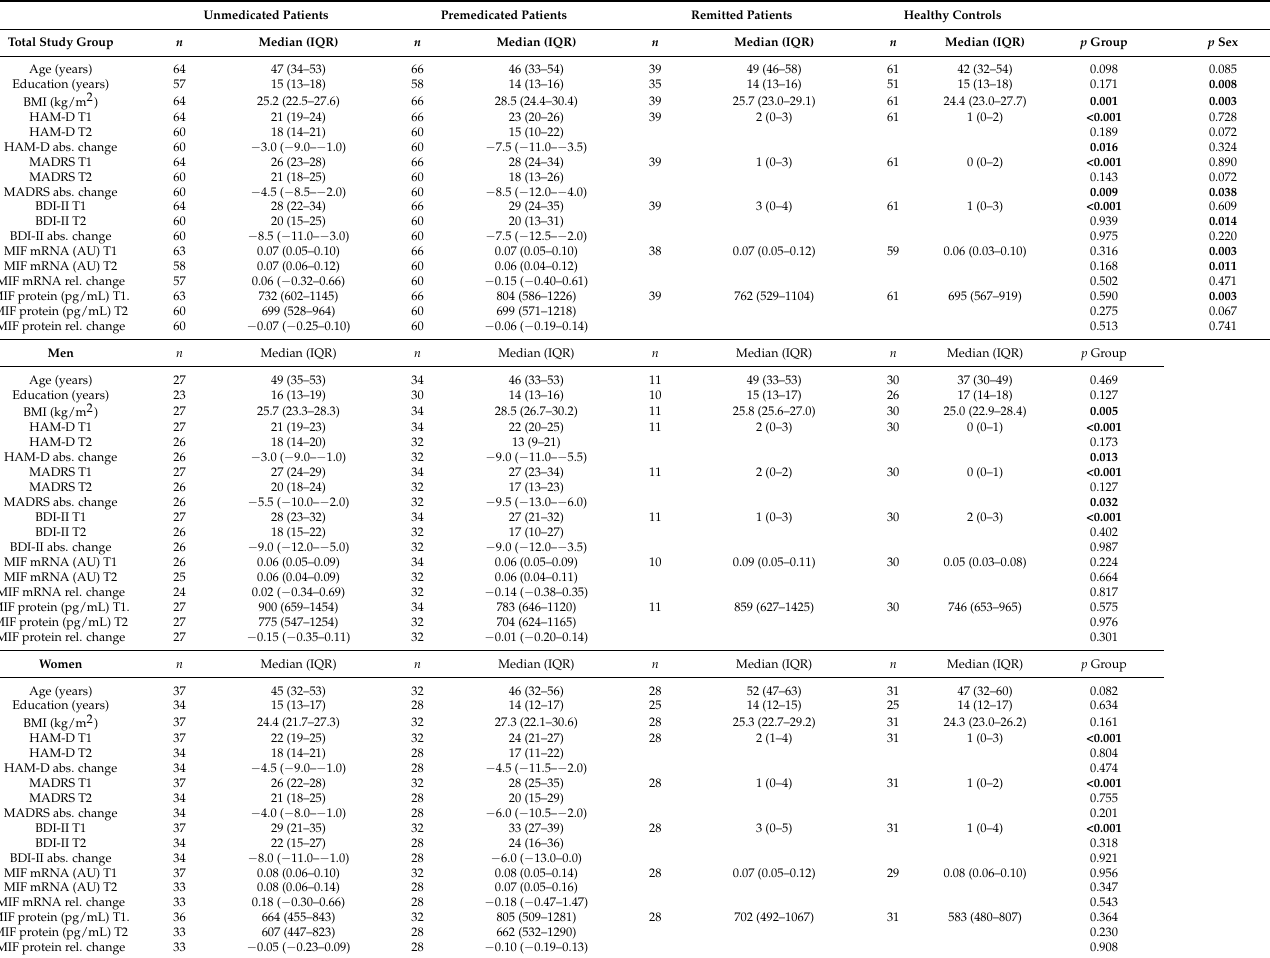
Table 1. Cohort characteristics. (T1 at inclusion; T2 at follow-up; IQR, interquartile range; AU, arbitrary units, fold expression compared with reference genes; p < 0.05 bold for group and sex differences from nonparametric tests).